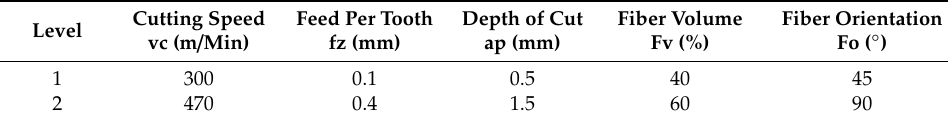
Table 1. Variables and levels.